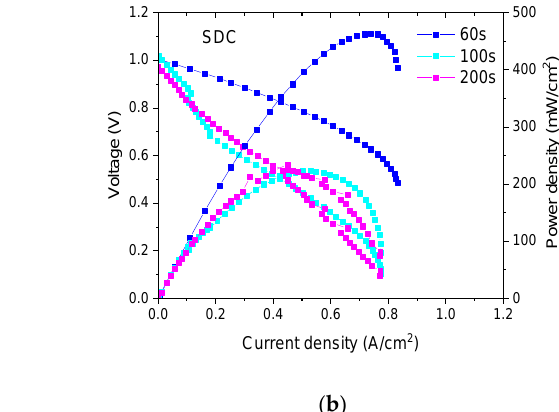
Figure 2. I – V – P curve of cells by sweeping on different time intervals ( a ) CeO 2 ; ( b ) 4SDC-SnO 2 electrolyte.